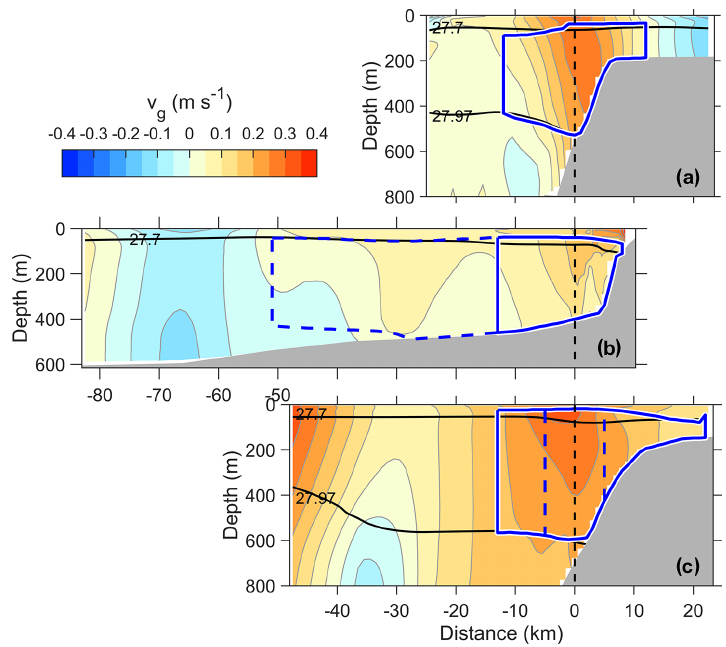
Figure 4. Distribution of absolute geostrophic velocity, v g , along sections (a) A, (b) B and (c) C. Other details are as in Fig.